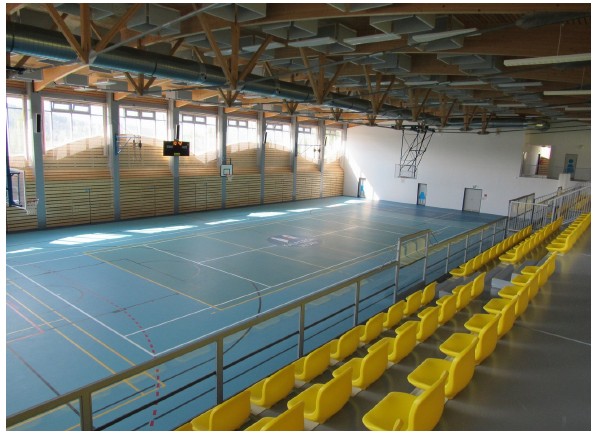
Figure 2: Sport facility in Kašperské Hory – playing area with perma- nent spectator